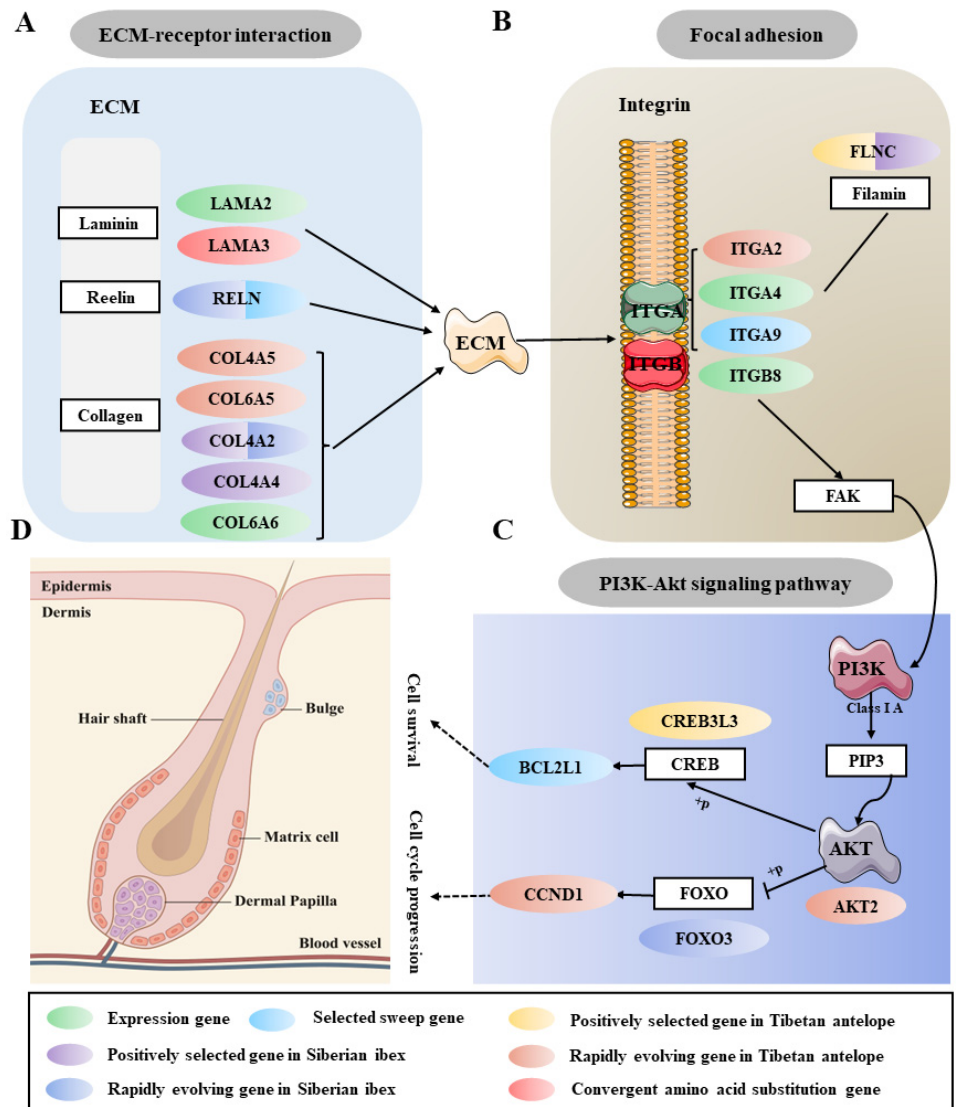
Figure 6. Genes and pathways related to cashmere traits under selection pressure. ( A ) Many extra- cellular matrix glycoprotein genes in the ECM-receptor interaction pathway may help to maintain cell adhesion and epithelial morphogenesis. ( B ) The integrin α and β subunit (ITGA/ITGB) family genes mediate cell adhesion to the extracellular matrix. ( C ) The genes in the PI3K-Akt signaling pathway are associated with cell survival and cell cycle progression. ( D ) Diagram of hair follicle structure. The results are based on PSGs, REGs, convergent genes, selected candidate genes and expressed genes. Different colors represent different gene sets; two colors indicate that the gene is present in both gene sets.